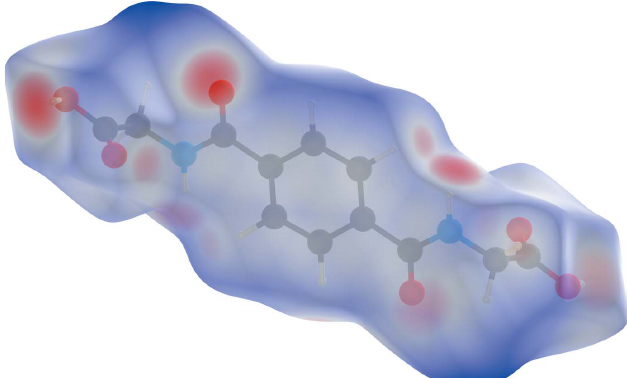
Figure 8 Hirshfeld surface for the N , N 0 -(1,4-phenylenedicarbonyl)diglycine solvent molecule with d norm over the range (cid:4) 0.6806 to 1.9484 a.u.. The surface is drawn with transparency; red spots indicate the strongest intermolecular interactions.